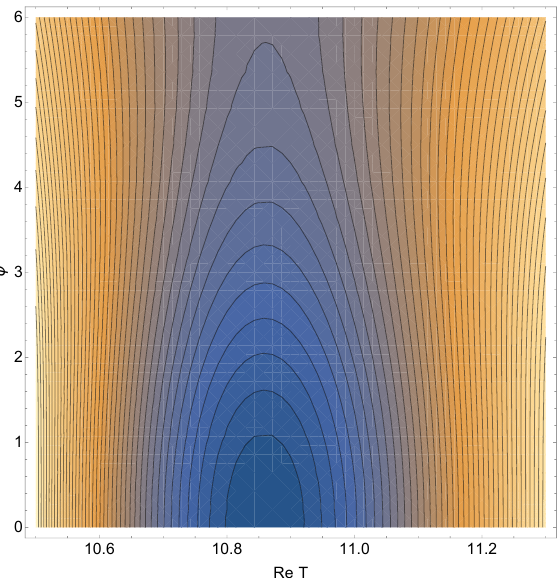
Figure 5 . Scalar potential evaluated in the (Re T; ’ ) plane for the set of parameters (3.71) where colder colours mean smaller values of V